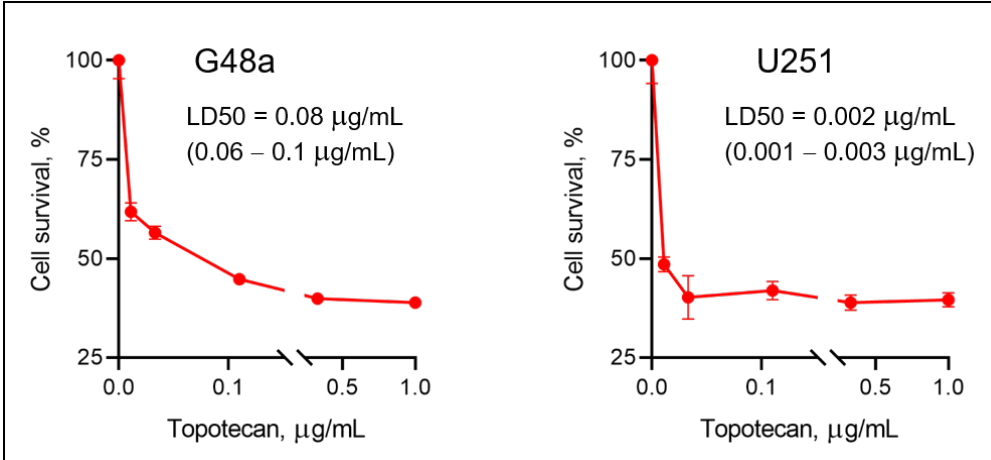
Figure 1. Cytotoxic effect of topotecan on G48a and U251 human glioblastoma cells. G48a and U251 cell cultures were treated with topotecan (0.012–1 µ g/mL) and assayed for survival 24 h post-treatment ( n = 4). Doses of topotecan inducing death of 50% of G48a and U251 cells (LD50) were calculated using GraphPad Prism software.